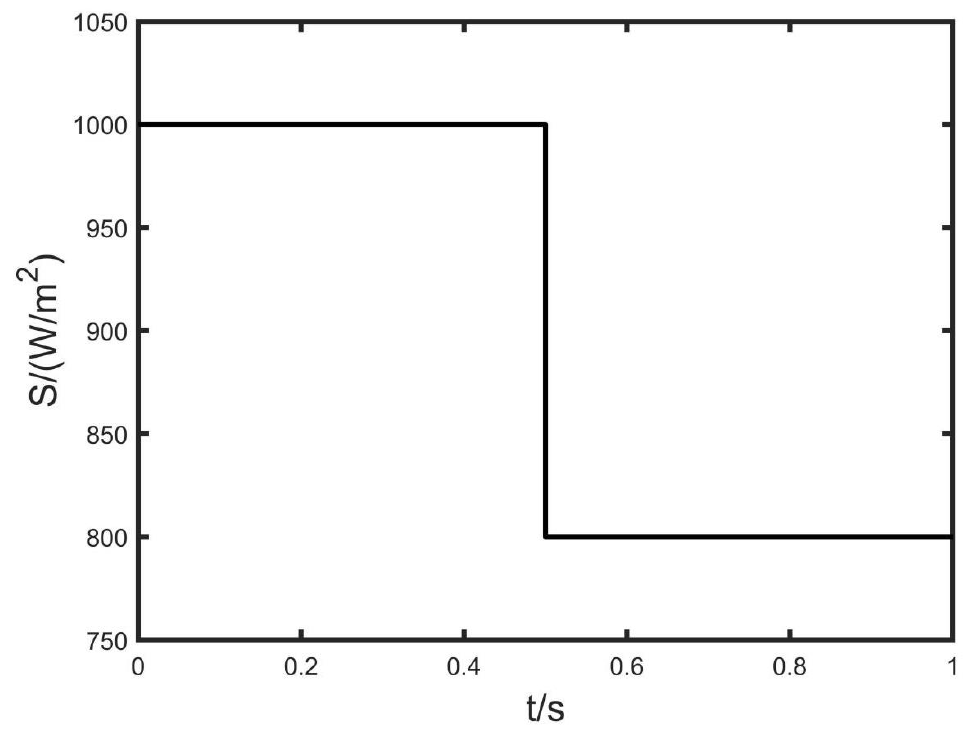
Figure 12. Adaptive adjustment curve of